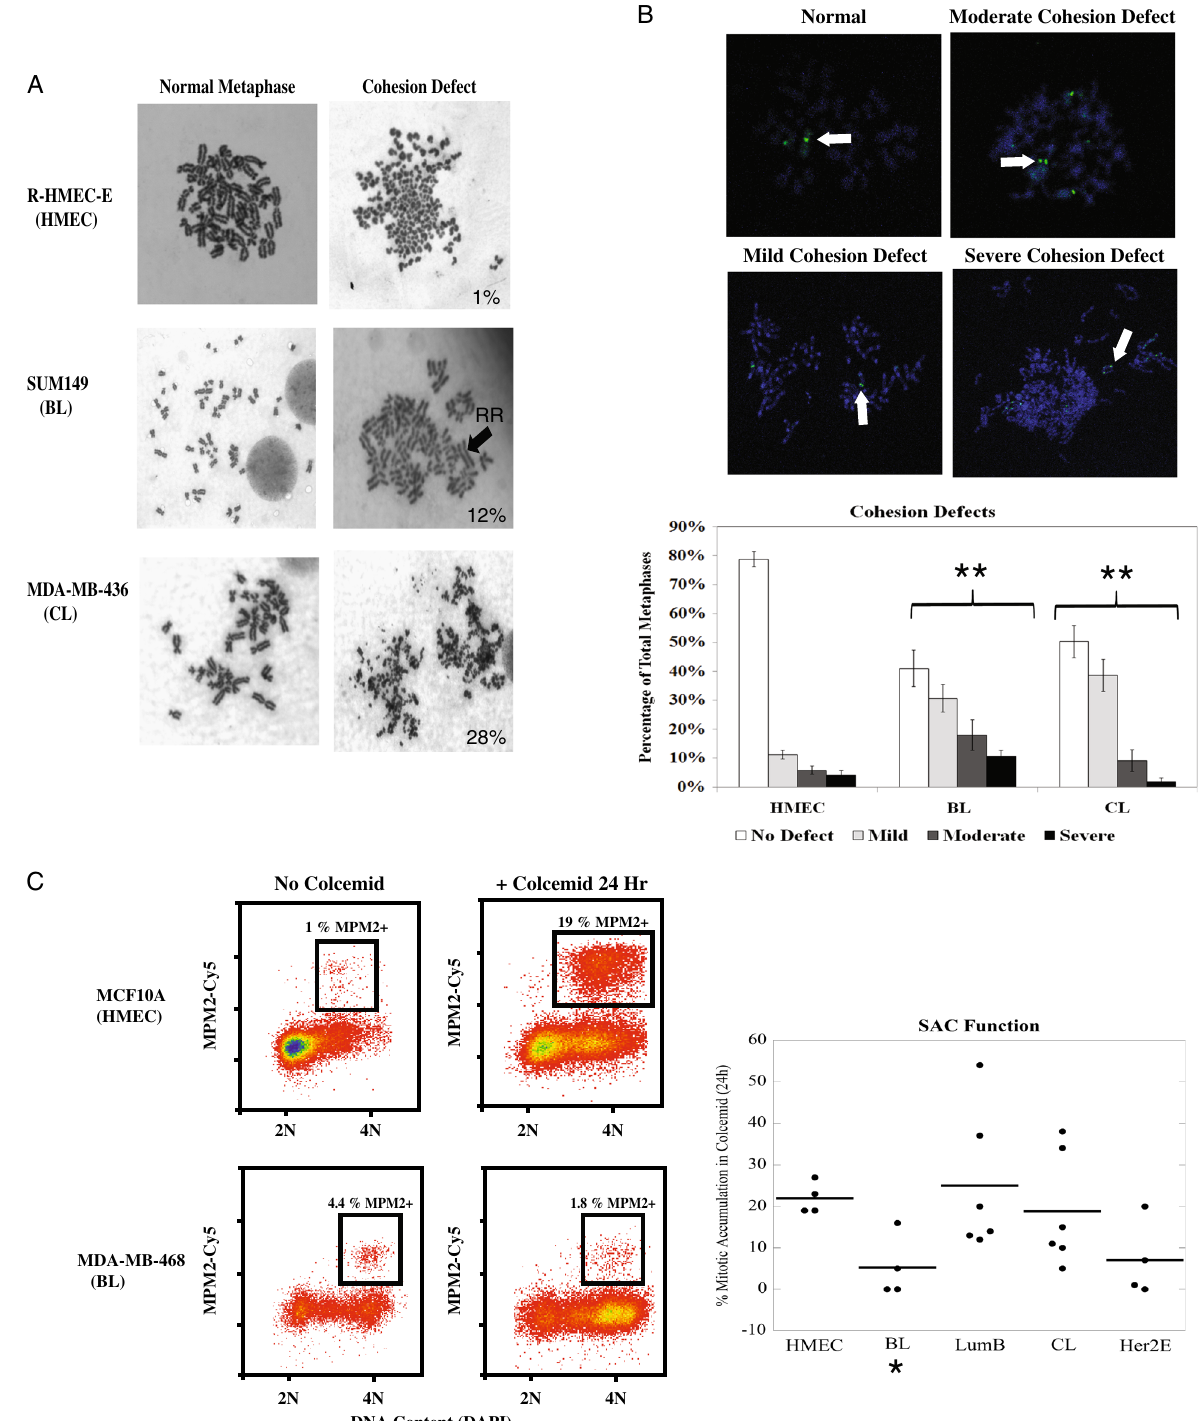
Fig. 4 The BL and CL cell line classes exhibit chromatid cohesion defects; the BL class also harbors a defective SAC. a Examples of cohesion defects observed in metaphase. The percentages of cells containing cohesion defects is shown for each cell line in the lower right corner of the cohesion defect picture. A “ railroad ” (RR) chromosome lacking a centromeric constriction point is designated with a black arrow in the SUM149 cell line to exemplify a mild cohesion defect. A severe cohesion defect is exempli fi ed by the complete discohesion of the MDA-MB- 436 metaphase. b Representative examples of the severity of cohesion defects observed during FISH analysis (upper panels). White arrows designate the centromere used for cohesion defect classi fi cation. Quanti fi cation of cohesion defects ( lower panel ) demonstrate that both the BL and CL classes exhibited variation in the distribution of chromatid cohesion defect severity when compared to the HMECs. Results shown were obtained from at least four different biological replicates for each subtype. c Flow cytometry examples re fl ecting SAC function in an HMEC line (MCF10A) and a BL breast cancer line (MDA-MB-468). Individual cell line averages obtained from at least three independent experiments are shown with bold lines representing the class average; the BL class exhibited a decrease in SAC function ( right panel ). * p -value < 0.05, ** p -value that remains signi fi cant when controlling for false discovery rate